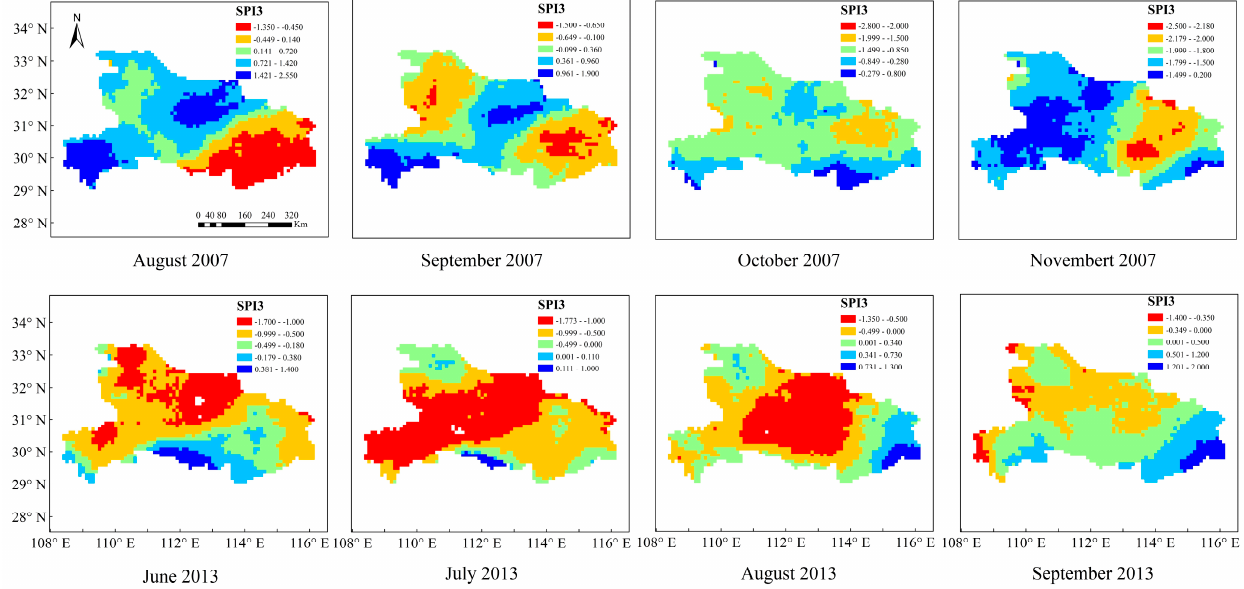
Figure 4. SPI-3 values based on the GPM data in August, September, October, and November 2007 and June, July, August, and September 2013.